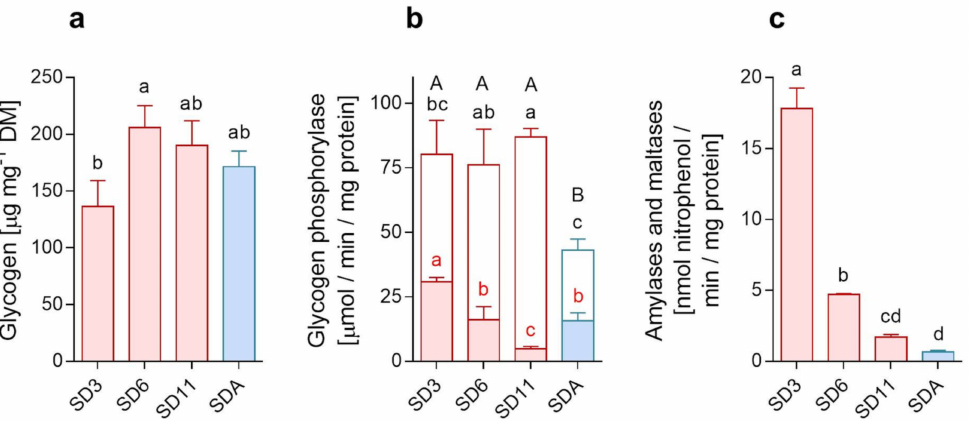
Figure 5. Glycogen, glycogen phosphorylase, amylases and maltases. Changes in ( a ) the total glycogen content, and the activities of ( b ) glycogen phosphorylase (white portions of the columns represent active form ‘a’ and colored portions inactive form ‘b’), and ( c ) amylases and maltases. All analyses were performed in extracts of whole body larvae of different acclimation variants (diapause maintenance: SD3, SD6, SD1 (red columns); cold acclimation: SDA (blue column); see Table 1)). Each column is a mean of 3 biological replicates. Means were compared using one-way ANOVAs followed by Bonnferoni’s multiple comparison tests (different letters indicate significantly different means; in panel b: the capital letters show differences between total activities, while the lower-case letters show differences between activities of the inactive (red font) and active (black font) forms of the glycogen